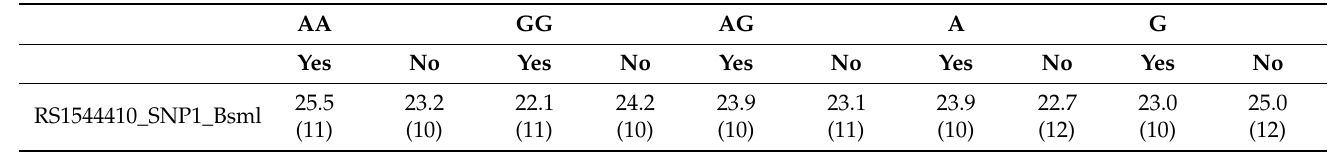
Table 3. Mean (SD) vitamin D concentrations (ng/mL) according to presence or absence of genotypes and allele distribution of four VDR gene